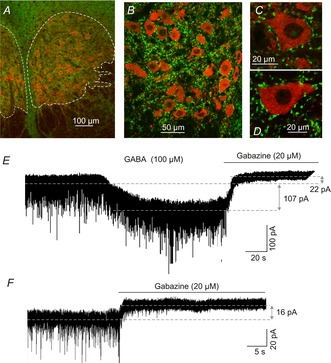
GABA inputs and currents in MNs of the rat oculomotor nucleusA–D, vesicular transporter of GABA (VGAT, green) within the boundaries of the rat oculomotor nucleus (delineated by dashed lines, A), in the neuropil (B), and in close association with MN cell bodies (C) and (D). MNs were identified by their positive immunoreactivity against choline acetyltransferase (red). E, inward current evoked by application of 100 μm GABA. This current (107 pA) was mediated by GABAA receptors as it was blocked by 20 μm gabazine. F, gabazine injection (20 μm) blocked the spontaneous inhibitory postsynaptic currents and revealed a tonic current of 16 pA in the illustrated MN. This current can also be seen in (E) after gabazine application (22 pA). MNs, motoneurons.